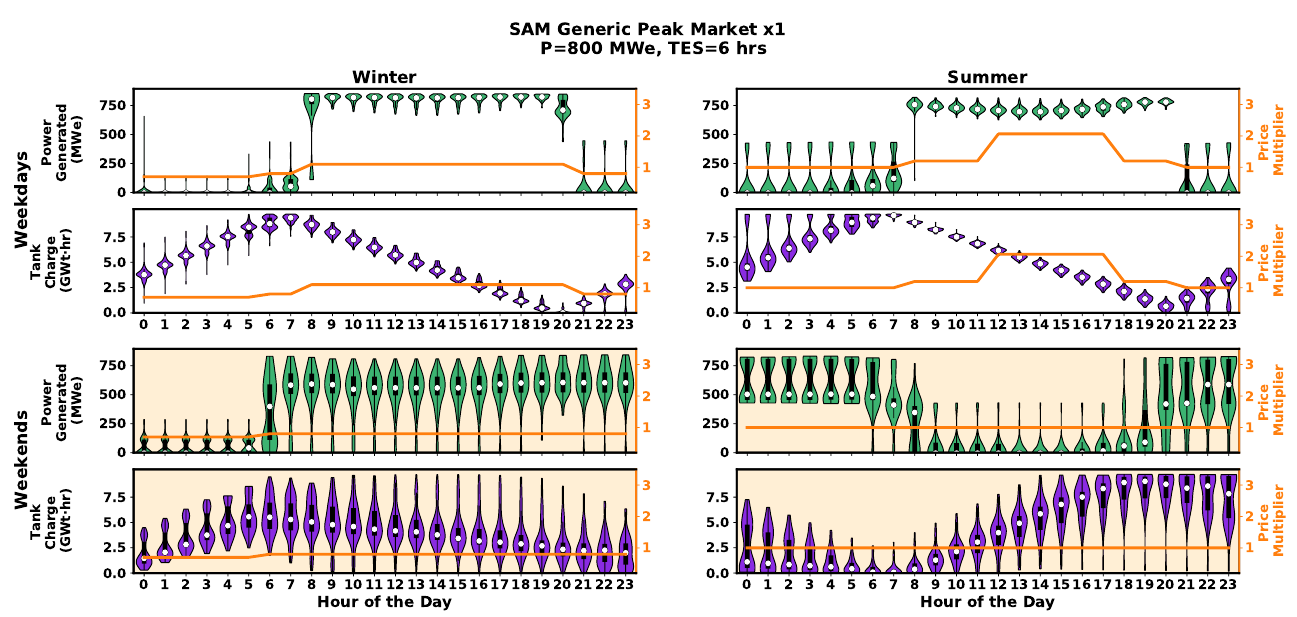
Figure 6. Hourly violin plot distributions for a year of simulated electric power and stored energy levels. Computed for a 800 MW e turbine with 6 h of TES under SAM generic peak market prices. Median value for each hour is shown as a white circle and the black vertical rectangle demarcates 25th and 75th percentiles. Distributions are split between winter and summer price schedules as well as weekday and weekend prices; price multipliers are shown on the right axis of each subplot.